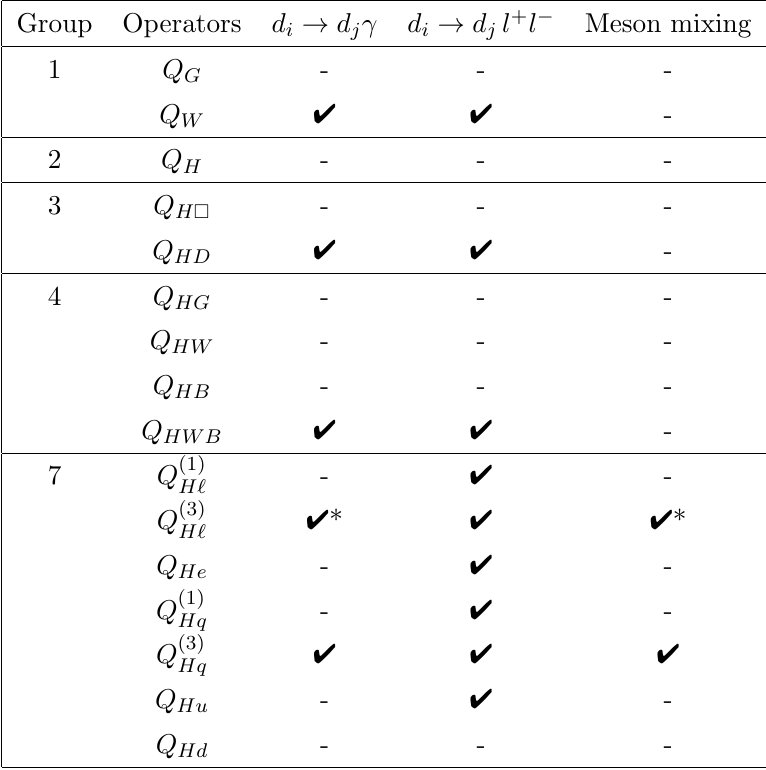
Table 1 . All operators with 2 or fewer fermions that are invariant under CP and the U(3) 5 (cid:13)avour symmetry. Ticks indicate that they contribute to the FCNC processes we consider. An asterisk ( (cid:3) ) signi(cid:12)es that the contribution is only indirect, via e(cid:11)ects in input parameter